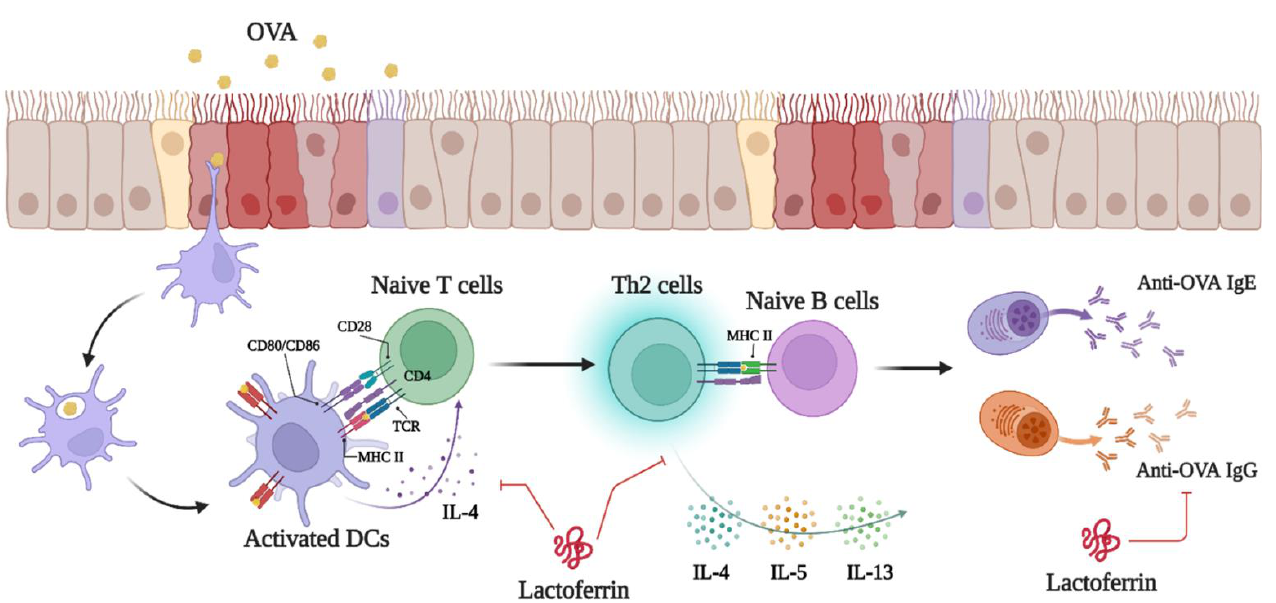
Figure 7. The protective mechanisms of lactoferrin in OVA-induced asthma. Three intraperitoneal injections of OVA and aerosol challenge in mice activated DCs and increased the level of Th2 immune responses to induce allergic asthma and AHR. The protective mechanism of LF in OVA-induced asthma may occur through the inhibition of DC activation and the Th2 cell immune response. This photo was created with BioRender.com software (accessed on 16 August